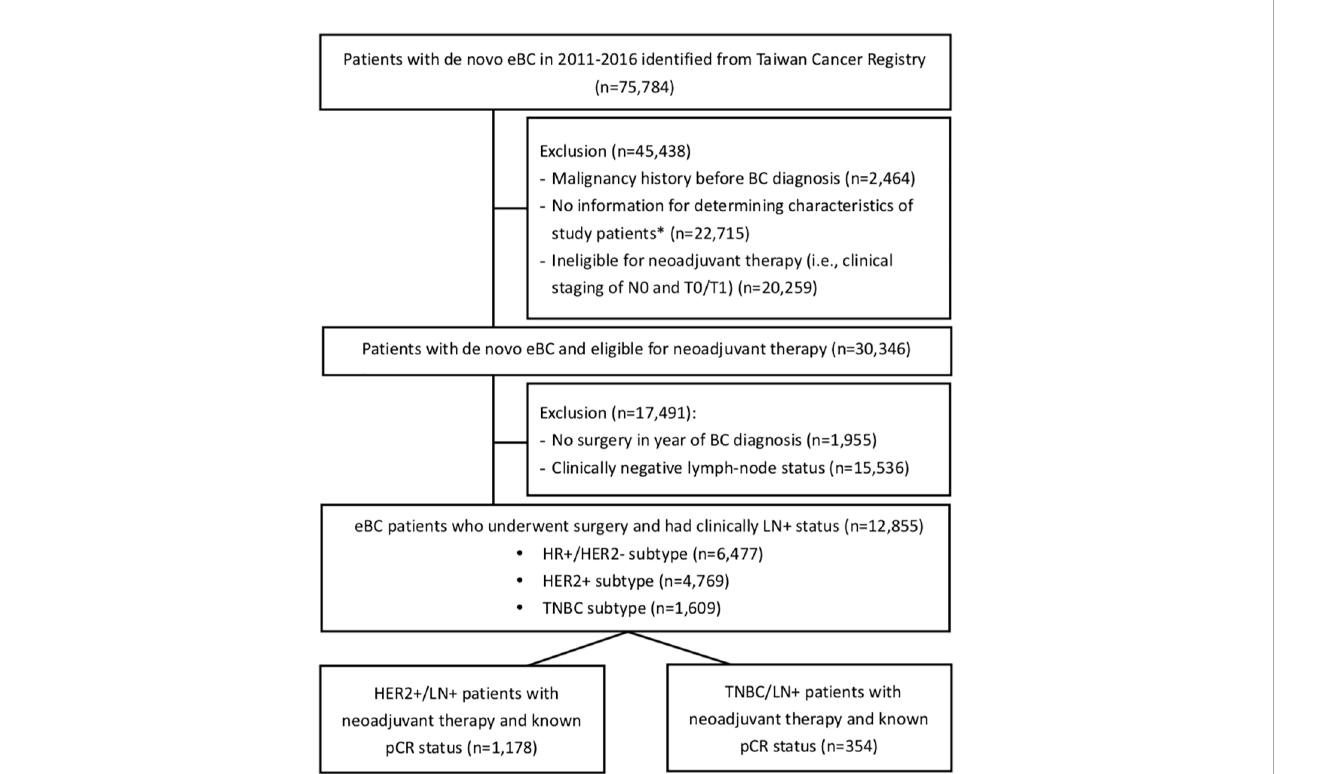
FIGURE 1 Flowchart of cohort selection. eBC, early breast cancer; BC, breast cancer; pCR, pathological complete response; HR, hormone receptor; HER2, human epidermal growth factor receptor-2; TNBC, triple-negative breast cancer; LN+, lymph-node positive. *The characteristics included the clinical staging of BC, subtype of BC (i.e., HR+ & HER2-, HER2+, and TNBC), diagnosis date of BC, and the eligibility of receiving neoadjuvant therapy (i.e., clinical N or T staging as the eligibility of receiving neoadjuvant